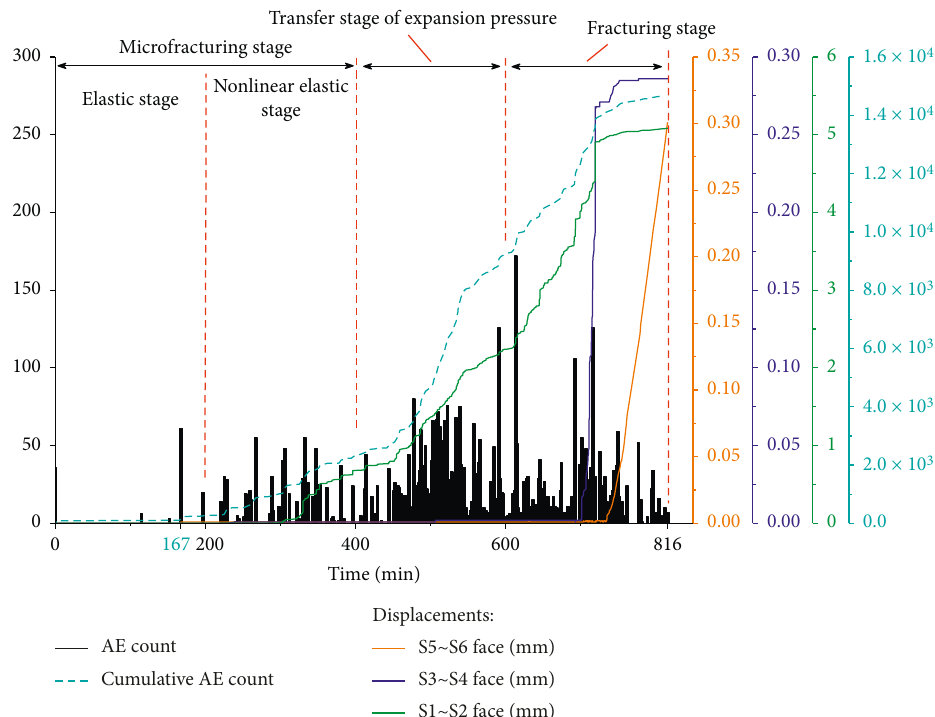
Figure 9: The relationships between displacement, AE event count, cumulative AE event count, and time before and after the fracturing of the C40-C10-C40 concrete test block.